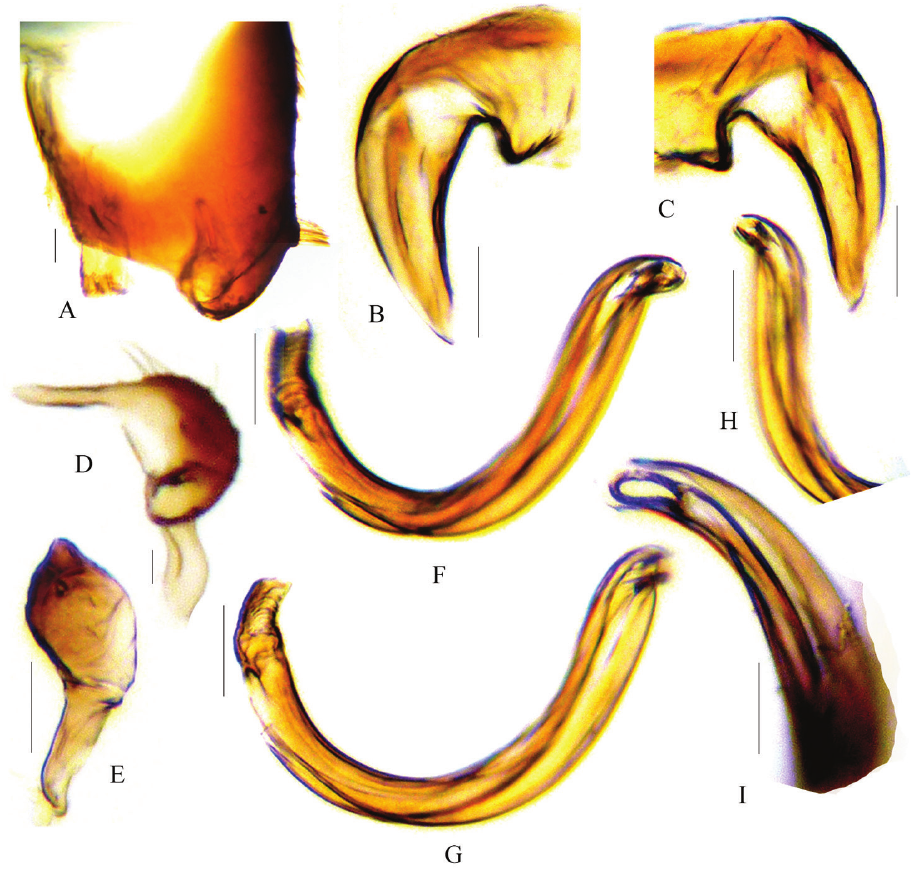
Figure 2. Male genital structures of Biromiris tomokunii . A Pygophore, right lateral view B–C Phal- lotheca D Left paramere, lateral view E Right paramere, anterior view F–G Endosoma H–I Apex of endosoma. Scale bars, A–H 0.2 mm; I